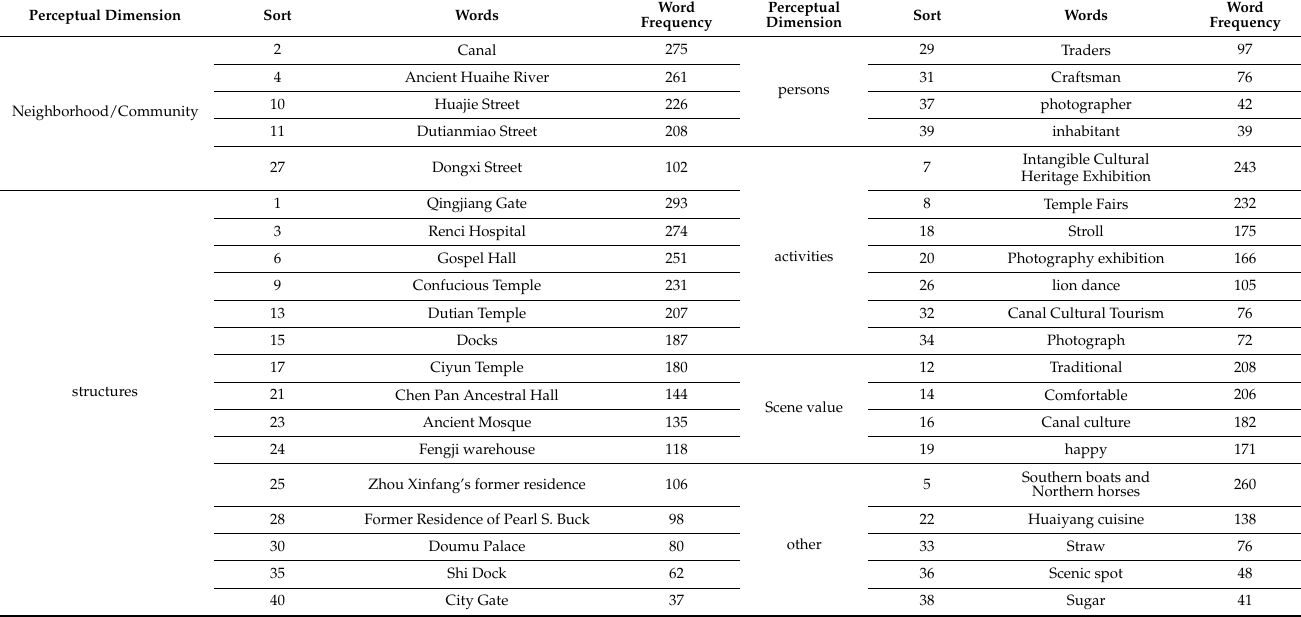
Table 3. Analysis table of the top 40 high-frequency